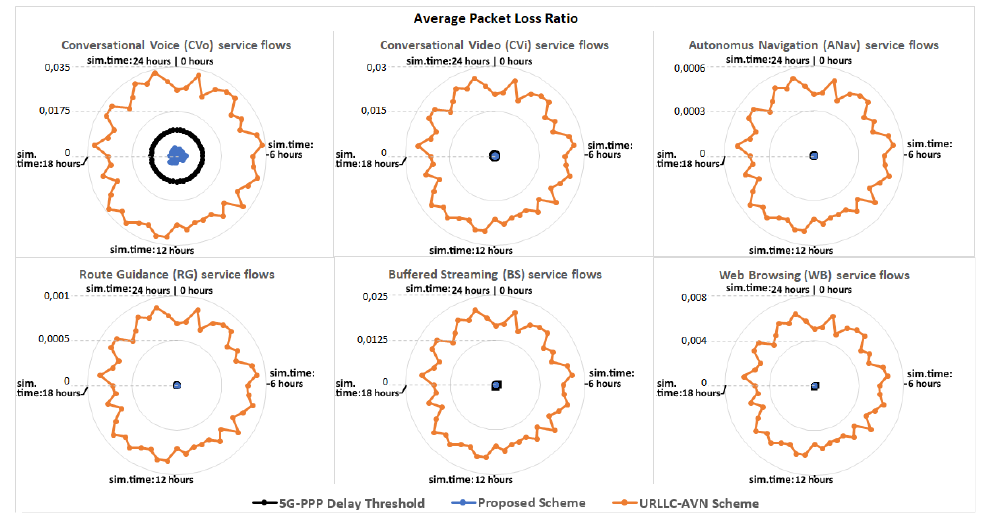
Figure 9. The average Packet Loss Ratio observed for each service type.